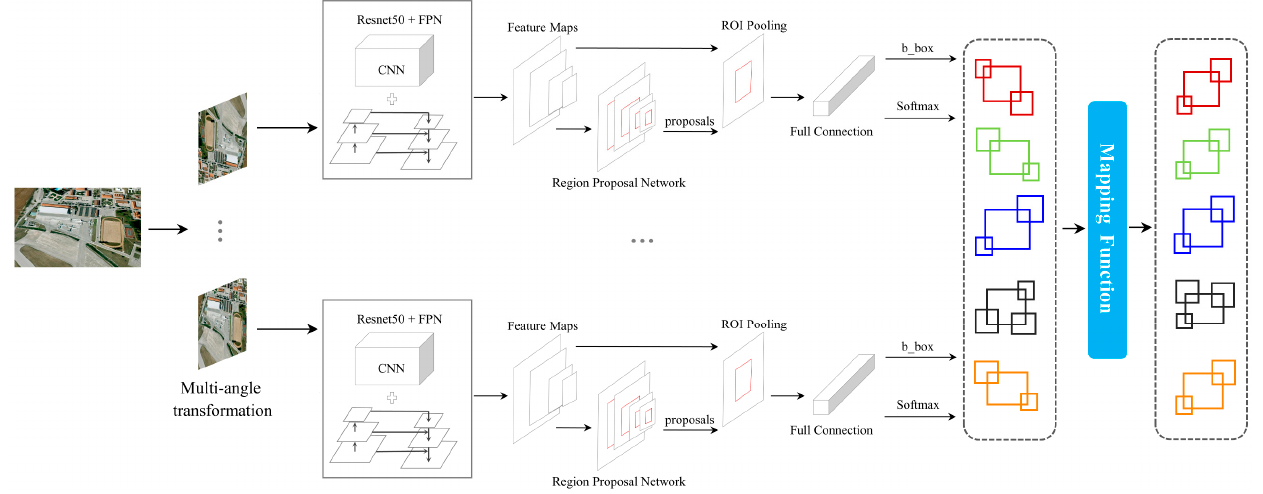
Figure 2. Aircraft detection process of remote sensing images based on multi ‐ angle features driven strategy.